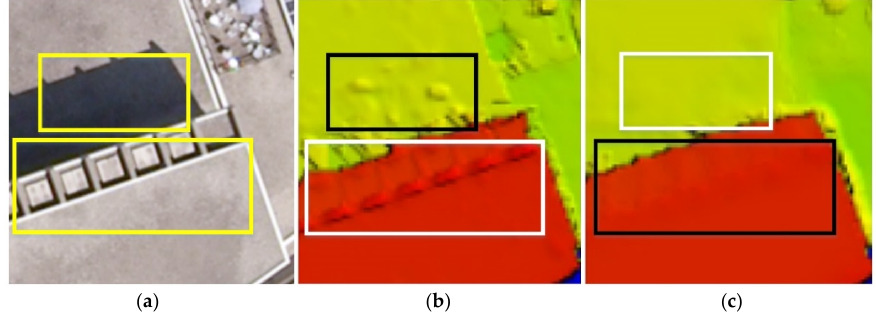
Figure 1. Comparison between the matching results using small and large windows: ( a ) the original image; ( b ) the matching result in 5 × 5 pixels window; ( c ) the matching result in 15 × 15 pixels window. Both ( b ) and ( c ) are estimated disparity images using Census-based Hamming distance as the matching cost [17,22] with semi-global matching optimization [23].